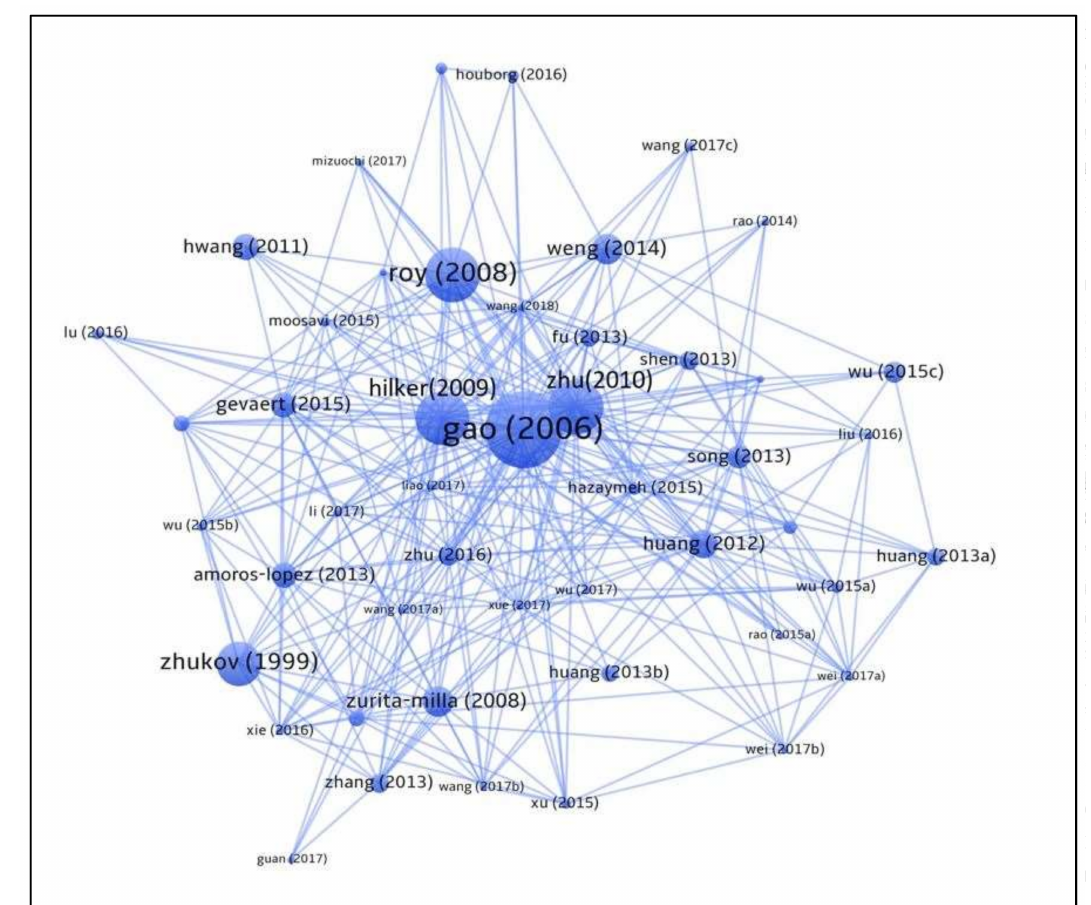
Figure 4. Citation map of the literature in Table 2. The size of nodes indicates the count of citations. The citation relationship was derived from Web of